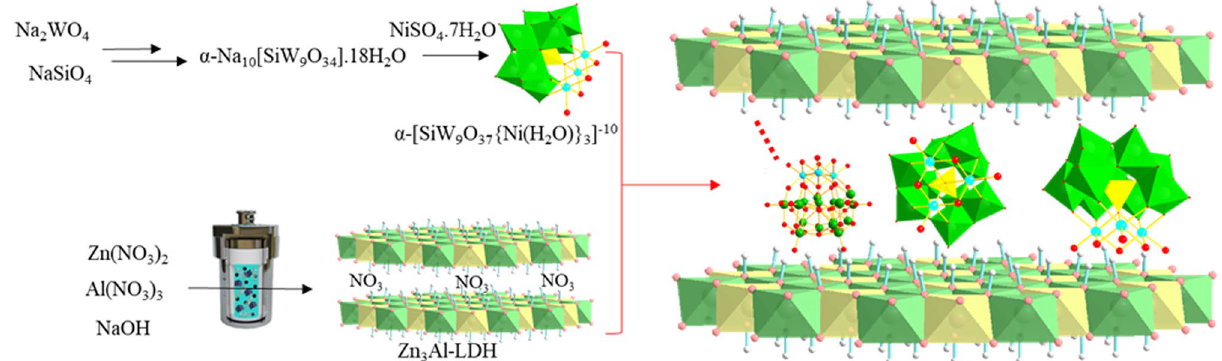
Figure 2. Schematic illustration of the preparation route for the intercalation of SiW 9 Ni 3 anions into Zn 3 Al-